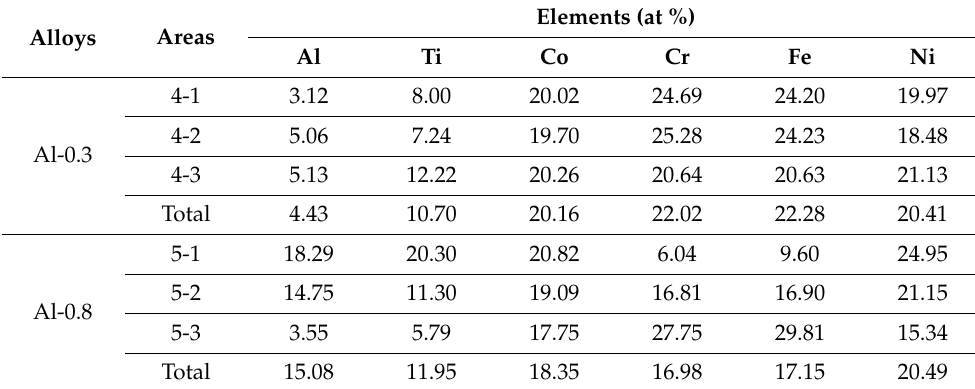
Table 4. EDS results for Al x CoCrFeNiTi0.5 HEAs. Alloys